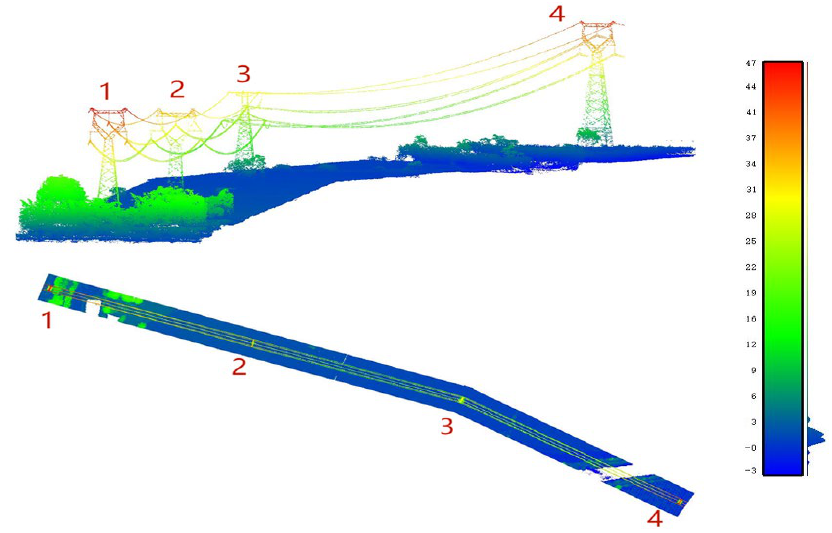
Figure 6. Power line point cloud.